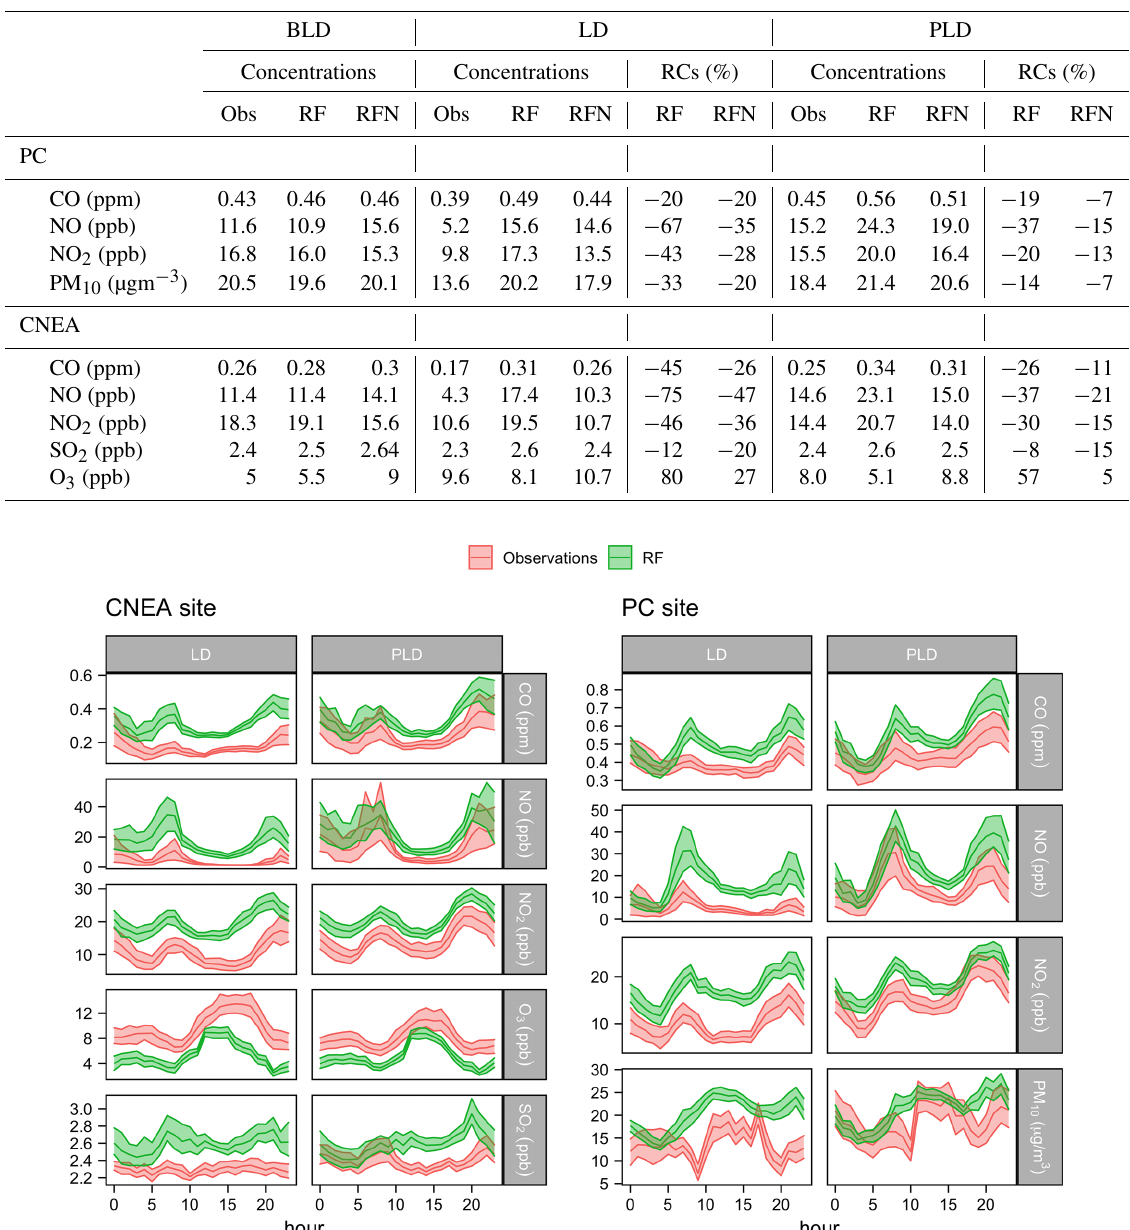
Table 5. Summary of the average concentrations for the BLD, the LD, and the PLD and the relative changes for the LD and the PLD for PC and CNEA sites estimated by RF and RFN. In every case, the RCs were calculated by considering the mean value for each period. In every case, Obs refers to observed concentrations.